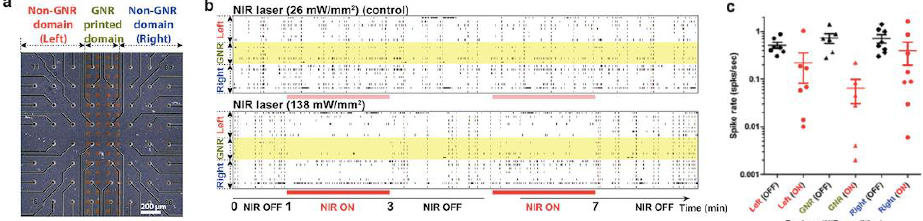
Figure 15. Synchronized neural network activity. ( a ) The cultured neuronal network (15 DIV) on an MEA chip, as imaged by dark-field microscopy. The chip has three sections—the GNR domain in the middle and the non-GNR domains on either side. Photothermally generated heat is only produced in the GNR domain. ( b ) The spike raster plots for all active electrodes ( n = 22 for control, n = 21 for 138 mW/mm 2 ) under NIR light stimulation with different light intensities (2 minutes of illumination followed by 2 minutes with the light off, repeated 5 times; the light illumination time window is indicated by color bars below each plot). ( c ) Average spike rate of active channels, shown according to domain and light illumination conditions (mean ± SEM). Reproduced with permission from [18].